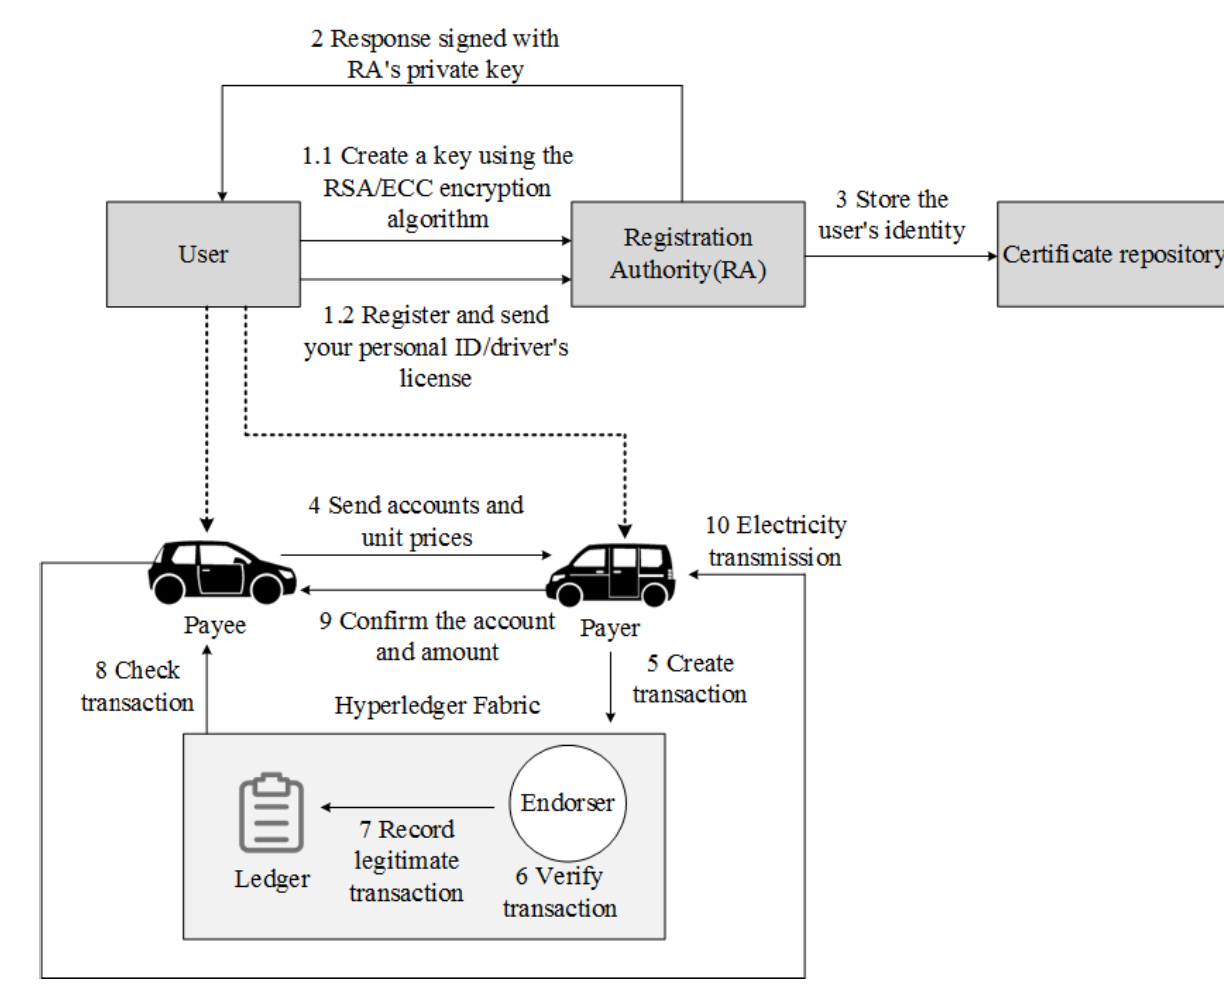
Figure 40. Reconstruction diagram of reference [72].